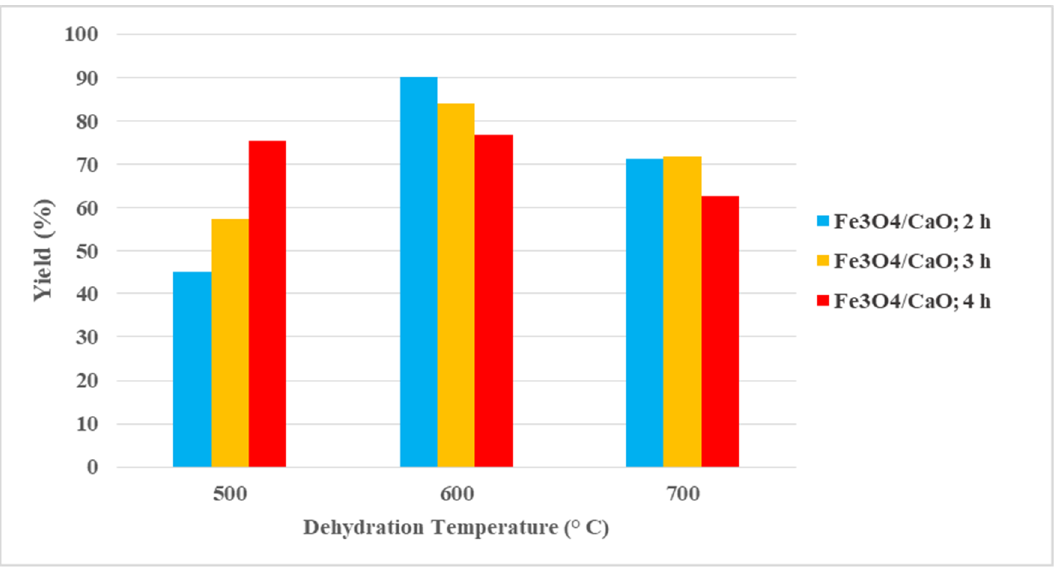
Figure 3. The yield of biodiesel produced from palm oil off-grade using Fe 3 O 4 /CaO catalyst prepared at various dehydration temperatures and reaction times.